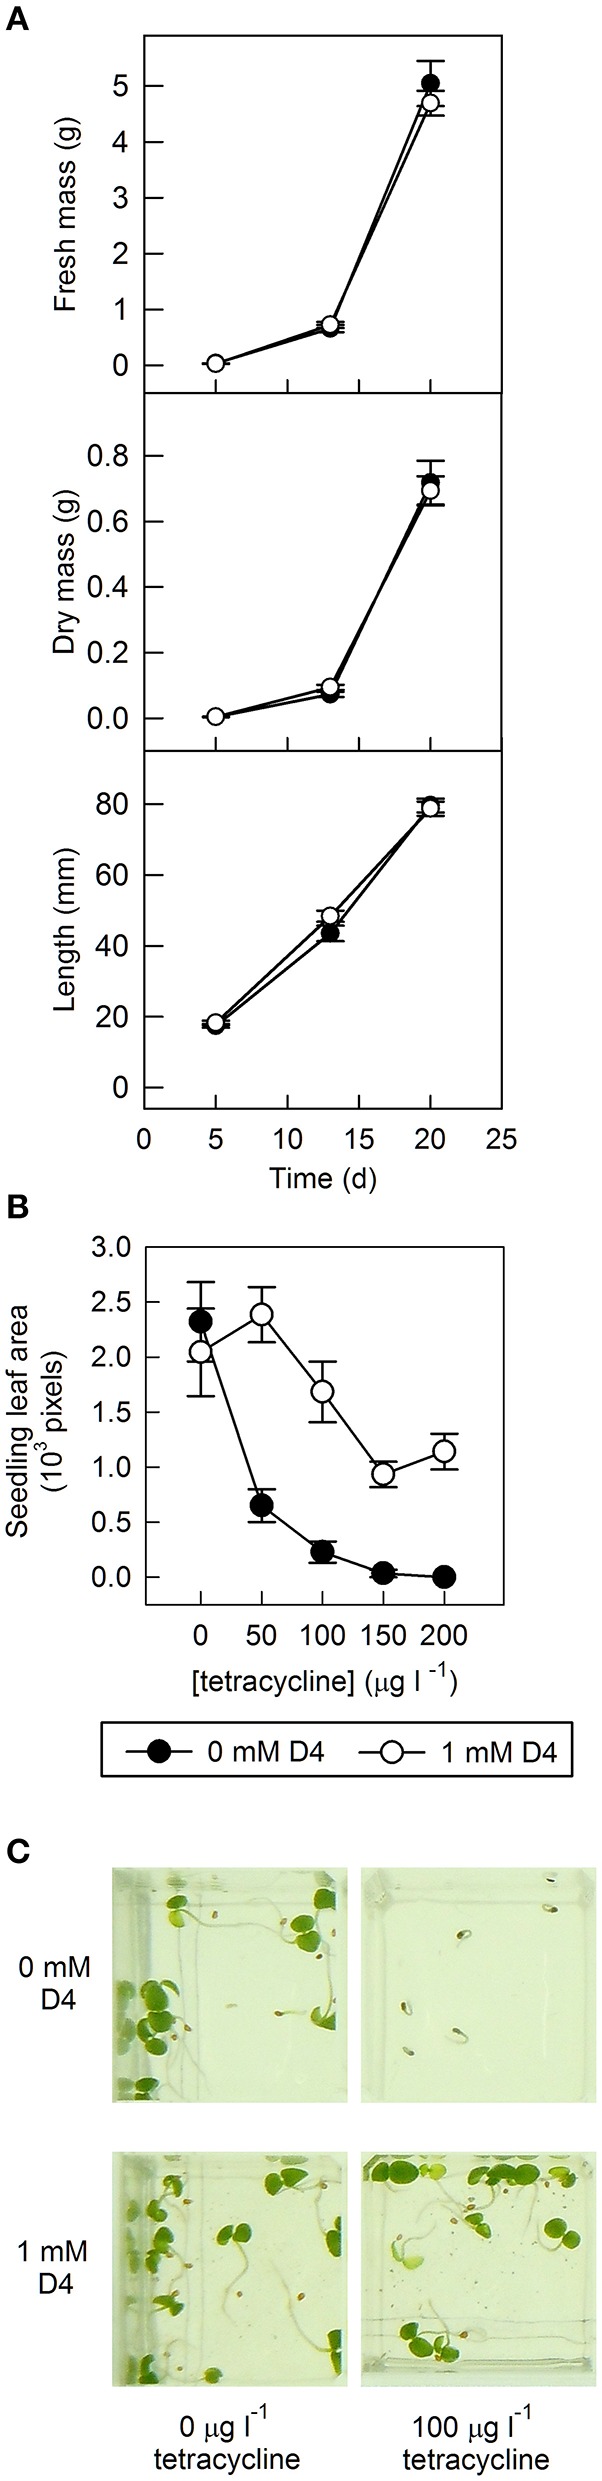
The effect of D4 on seedling vigor in tomato and tobacco overexpressing LeNCED1. (A)
LeNCED1-overexpressing tomato seed (sp12) were germinated on filter paper containing 0.1% DMSO with or without 1 mM D4, as indicated, and were transferred to soil following germination. Twenty shoots were harvested for measurement of dry mass, fresh mass, and length for each treatment at 5, 13, and 20 days post-germination. Error bars indicate standard error (n = 20). (B) Tobacco seed harboring tetracycline-inducible LeNCED1 were sown on 0.6% agar containing ½ MS salts and 0–200 μg l−1 tetracycline with and without 1 mM D4 in 0.2% DMSO. Seed were incubated at 25°C in darkness for 6 days and then transferred to light conditions. Seedlings were photographed 10 days after sowing and green leaf area of seedlings was quantified using ImageJ. Error bars indicate standard error (n = 5). (C) Images of seedlings in plate wells representative of labeled treatments.